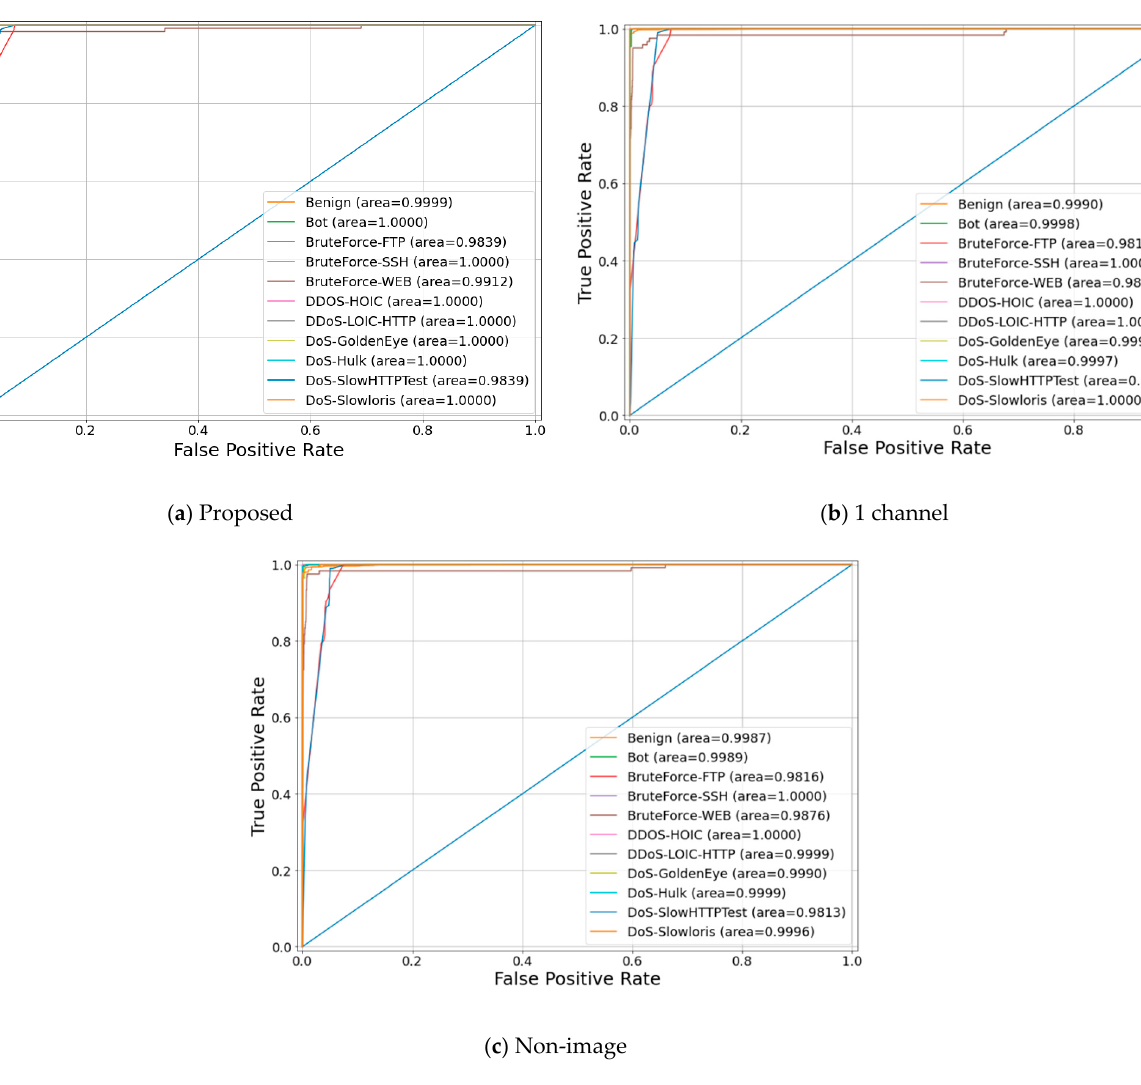
Figure 10. CSE-CIC-IDS2018 ROC curves.